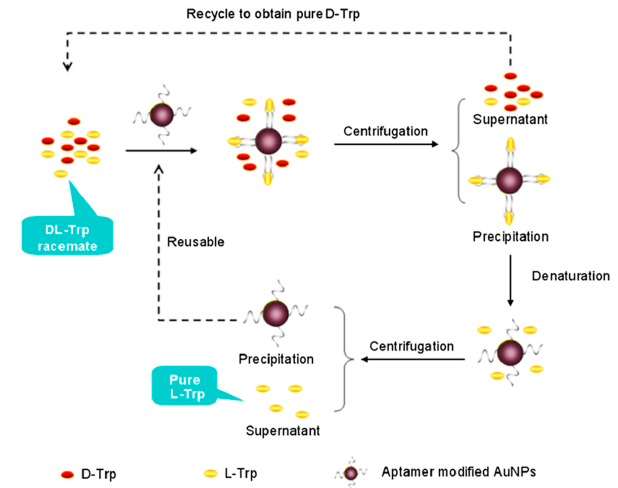
Figure 7. The schematic of the enantioseparation of D , L -Trp based on functional nucleic acids modified Au nanoparticles. The figure and the caption have been adapted with permission from [69], Copyright © 2013 Wiley.